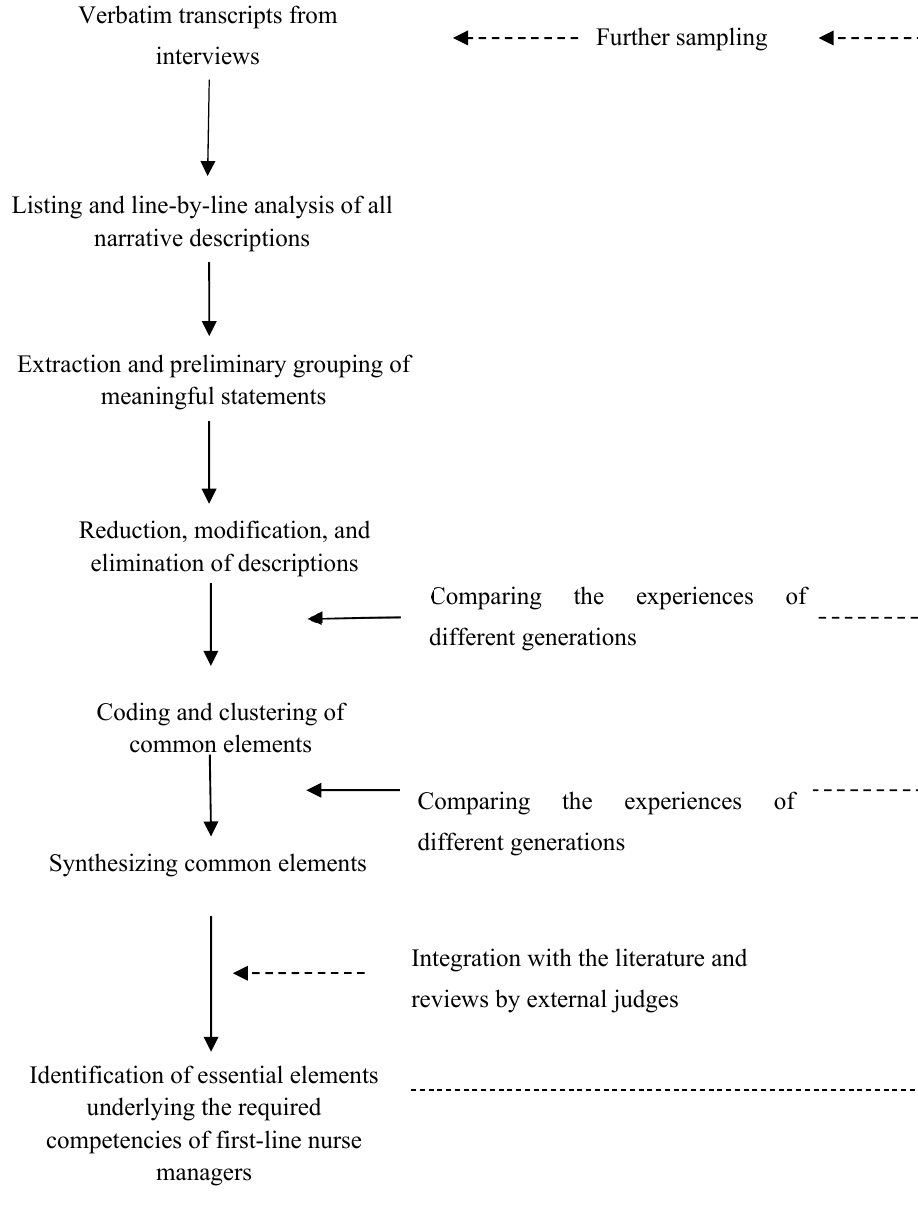
Figure 1. Processes involved in the phenomenological analysis.